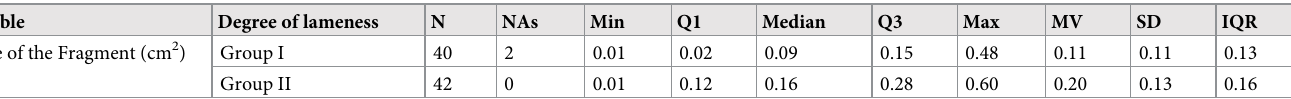
Size of the fragment Forelimbs from group II, in regards to the median and the MV fragment sizes, had almost twice as large compared to those from group I (Group I: Median 0.09cm 2 ; MV 0.11cm 2 . Group II: Median 0.16cm 2 ; MV 0.20cm 2 ). The 1st quartile, 3rd quartile and maximum also took higher values in group II in compari- son to group I (Tables 5 and 7, S1 Fig). Regarding the categories ‘fragment dislocation’ and ‘fragment size’ in relation the results of Table 8 and the Boxplot S2 Fig. (Supporting information) show that there is a local significance (p = 0.001). A larger fragment is more likely to dislocate than a smaller fragment.